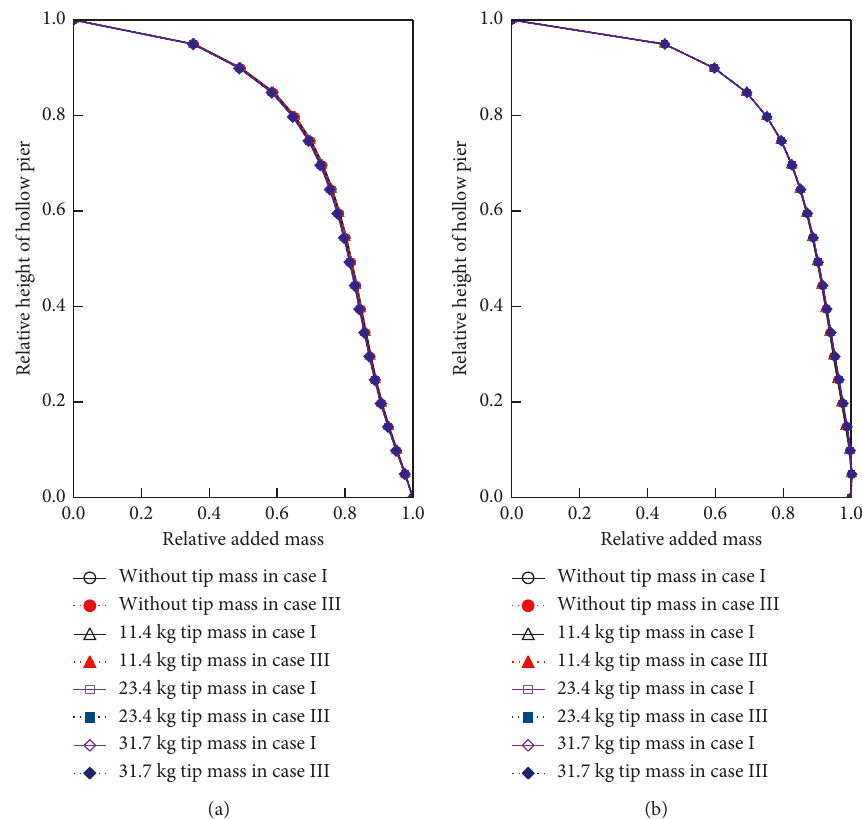
Figure 15: Comparison of the relative added mass distributions along the specimen corresponding to a water level of H (a) case III and case I along the x -axis; (b) case III and case I along the y